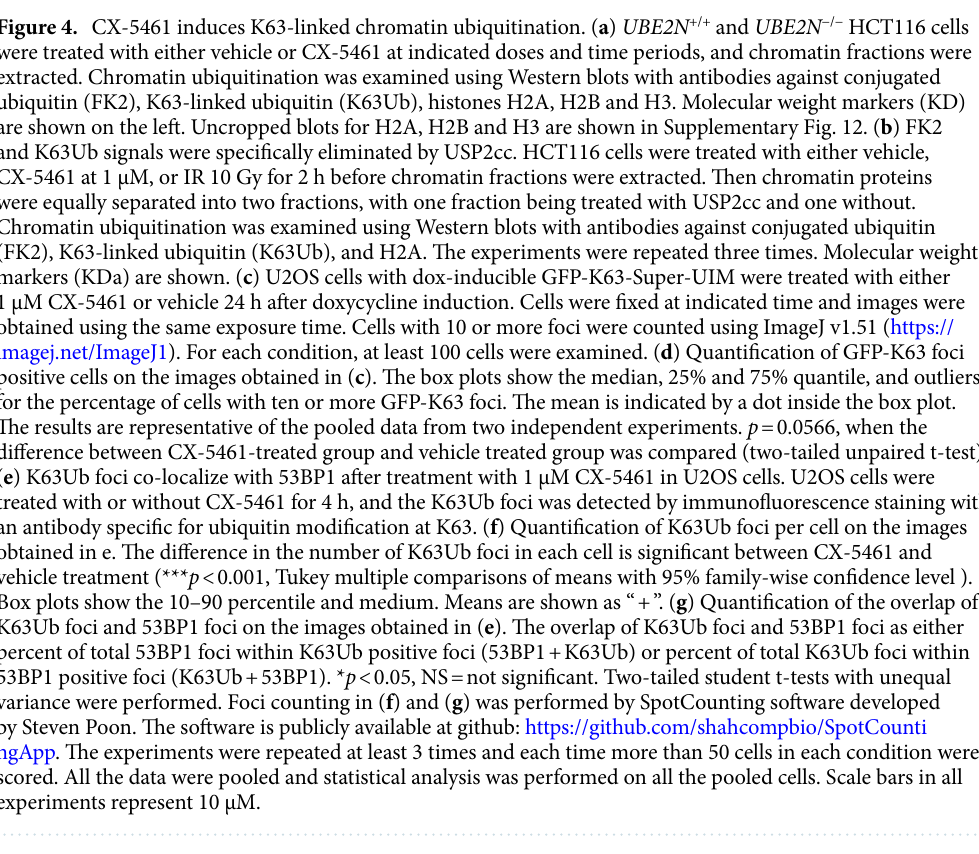
Figure 4. CX-5461 induces K63-linked chromatin ubiquitination. ( a ) UBE2N +/+ and UBE2N −/− HCT116 cells were treated with either vehicle or CX-5461 at indicated doses and time periods, and chromatin fractions were extracted. Chromatin ubiquitination was examined using Western blots with antibodies against conjugated ubiquitin (FK2), K63-linked ubiquitin (K63Ub), histones H2A, H2B and H3. Molecular weight markers (KD) are shown on the left. Uncropped blots for H2A, H2B and H3 are shown in Supplementary Fig. 12. ( b ) FK2 and K63Ub signals were specifically eliminated by USP2cc. HCT116 cells were treated with either vehicle, CX-5461 at 1 µM, or IR 10 Gy for 2 h before chromatin fractions were extracted. Then chromatin proteins were equally separated into two fractions, with one fraction being treated with USP2cc and one without. Chromatin ubiquitination was examined using Western blots with antibodies against conjugated ubiquitin (FK2), K63-linked ubiquitin (K63Ub), and H2A. The experiments were repeated three times. Molecular weight markers (KDa) are shown. ( c ) U2OS cells with dox-inducible GFP-K63-Super-UIM were treated with either 1 µM CX-5461 or vehicle 24 h after doxycycline induction. Cells were fixed at indicated time and images were obtained using the same exposure time. Cells with 10 or more foci were counted using ImageJ v1.51 (https:// imagej. net/ Image J1). For each condition, at least 100 cells were examined. ( d ) Quantification of GFP-K63 foci positive cells on the images obtained in ( c ). The box plots show the median, 25% and 75% quantile, and outliers for the percentage of cells with ten or more GFP-K63 foci. The mean is indicated by a dot inside the box plot. The results are representative of the pooled data from two independent experiments. p = 0.0566, when the difference between CX-5461-treated group and vehicle treated group was compared (two-tailed unpaired t-test). ( e ) K63Ub foci co-localize with 53BP1 after treatment with 1 µM CX-5461 in U2OS cells. U2OS cells were treated with or without CX-5461 for 4 h, and the K63Ub foci was detected by immunofluorescence staining with an antibody specific for ubiquitin modification at K63. ( f ) Quantification of K63Ub foci per cell on the images obtained in e. The difference in the number of K63Ub foci in each cell is significant between CX-5461 and vehicle treatment (*** p < 0.001, Tukey multiple comparisons of means with 95% family-wise confidence level ). Box plots show the 10–90 percentile and medium. Means are shown as “ + ”. ( g ) Quantification of the overlap of K63Ub foci and 53BP1 foci on the images obtained in ( e ). The overlap of K63Ub foci and 53BP1 foci as either percent of total 53BP1 foci within K63Ub positive foci (53BP1 + K63Ub) or percent of total K63Ub foci within 53BP1 positive foci (K63Ub + 53BP1). * p < 0.05, NS = not significant. Two-tailed student t-tests with unequal variance were performed. Foci counting in ( f ) and ( g ) was performed by SpotCounting software developed by Steven Poon. The software is publicly available at github: https:// github. com/ shahc ompbio/ SpotC ounti ngApp. The experiments were repeated at least 3 times and each time more than 50 cells in each condition were scored. All the data were pooled and statistical analysis was performed on all the pooled cells. Scale bars in all experiments represent 10